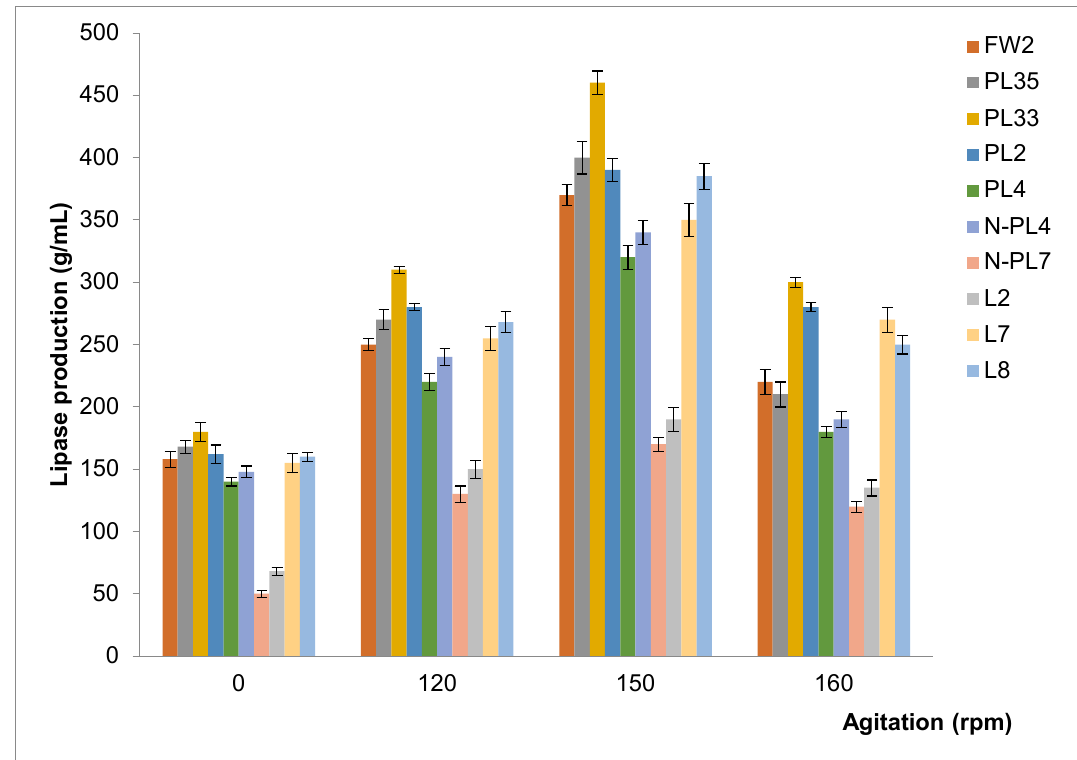
Figure 5. The effect of agitation on lipase production and growth of ten bacterial strains. Cultures were adjusted to a pH of 7, incubated at 30 °C at different agitations for 72 h. Experiments were performed in triplicate.